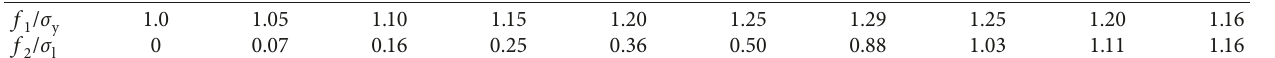
Table 8: Compressive strength of concrete under biaxial compression [25].